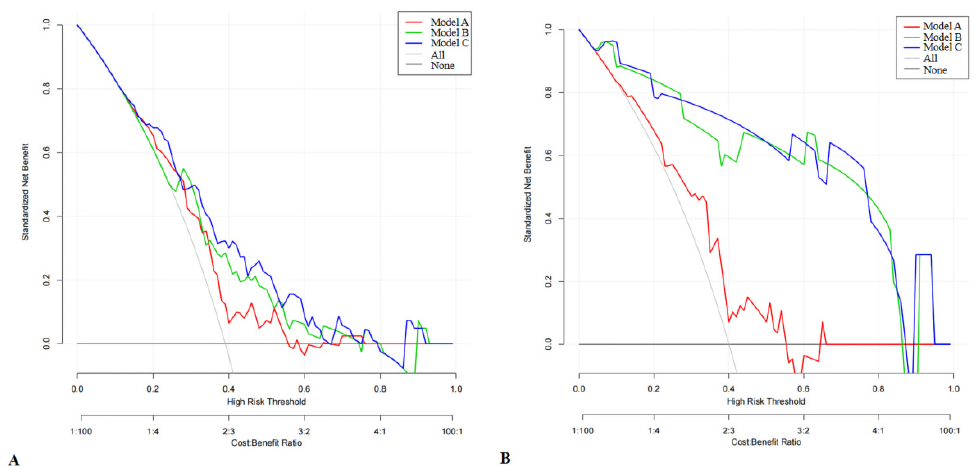
Figure 5. Decision curve analysis (DCA) of the three models in predicting intermediate-high SS. ( A ) Training set. ( B ) Validation set.